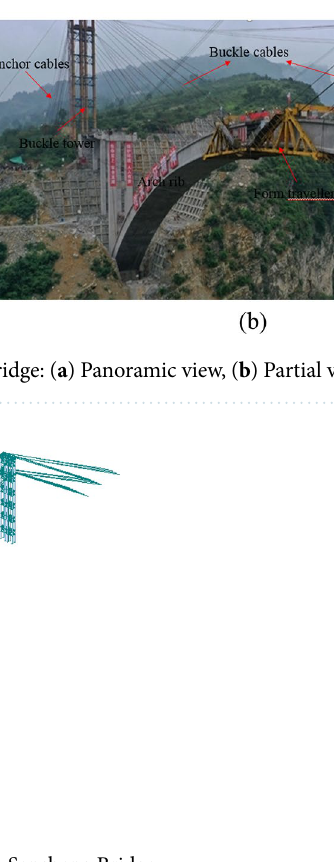
Figure 10. Finite element calculation model of Jiming Sansheng